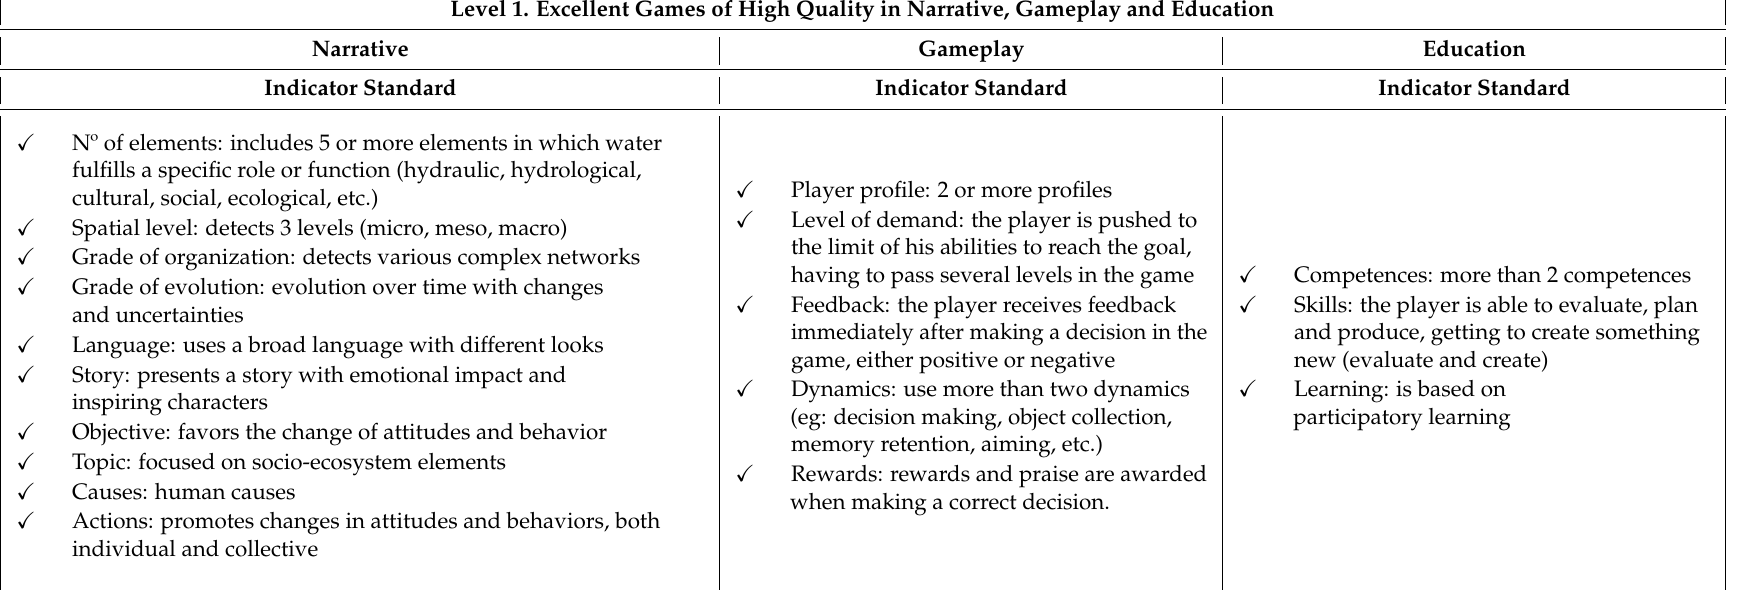
Table 3. Matrix with levels of specification for high, medium and low quality according to indicators and